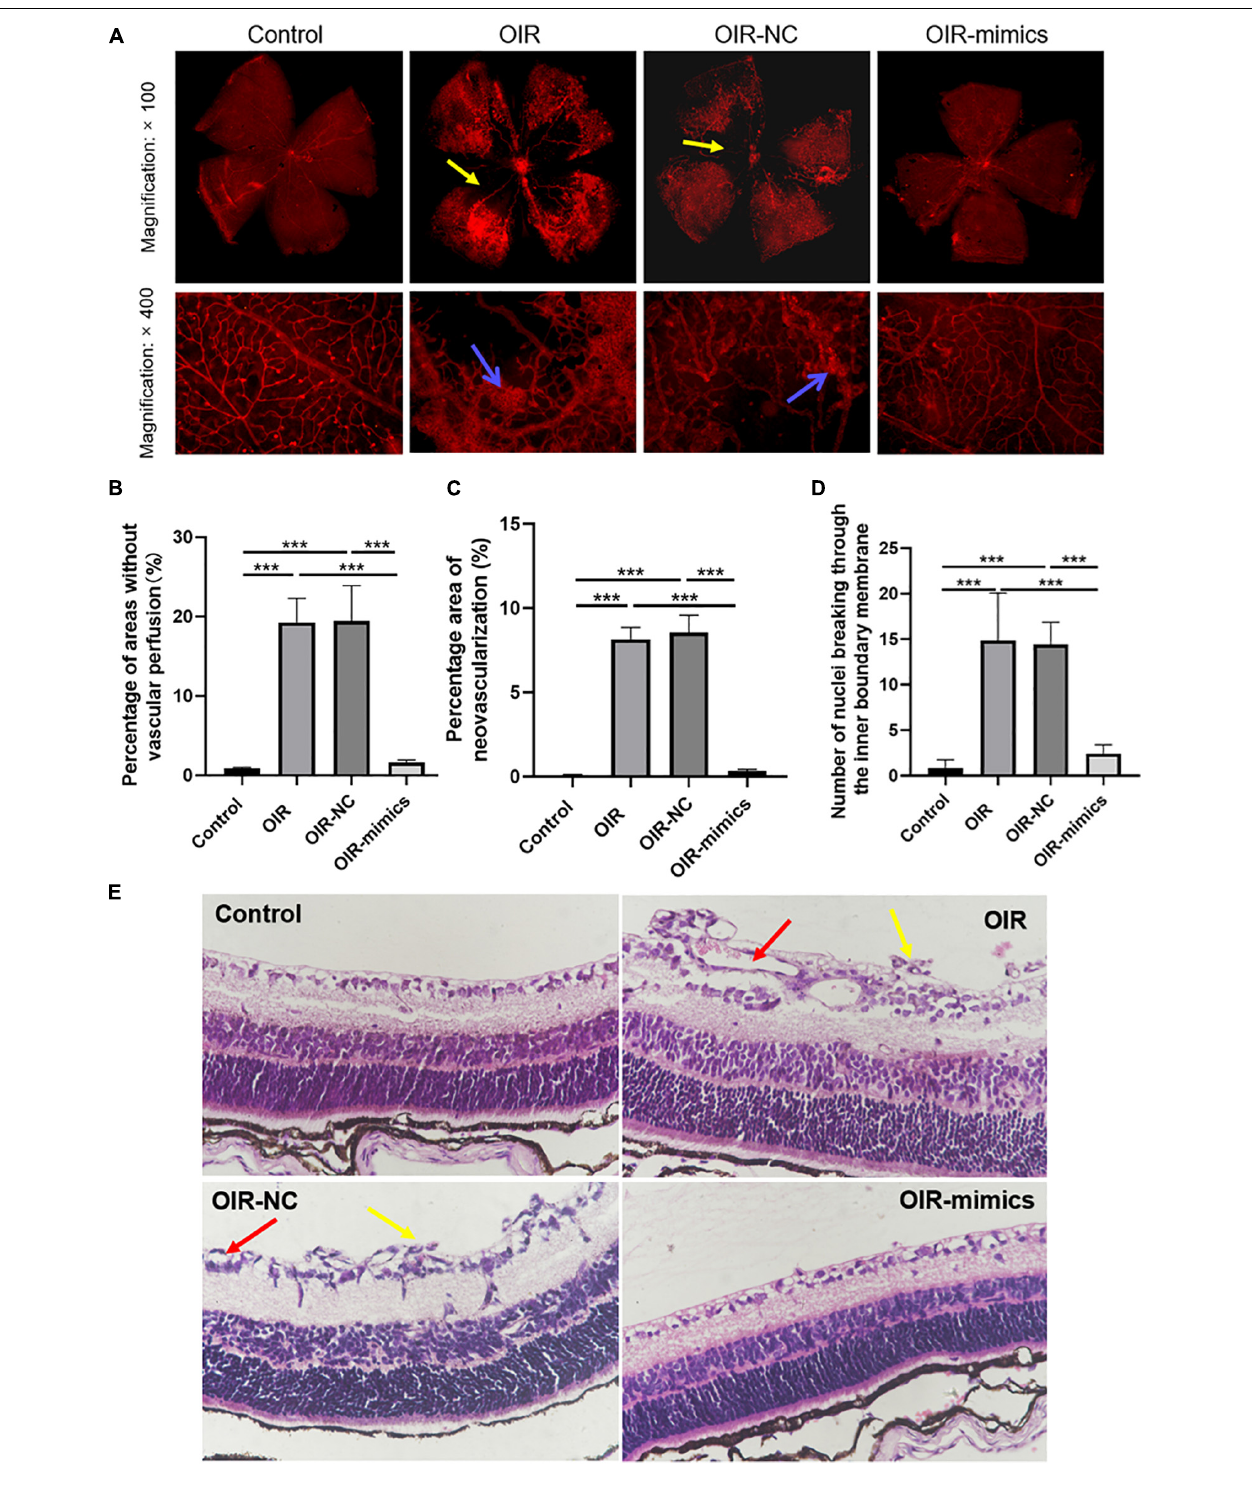
FIGURE 6 | Overexpression of miR-145-5p can reduce the degree of OIR retinal lesions. (A) Retinal vascular morphology of mice in different treatment groups, yellow arrows indicate non-perfusion area, blue arrows indicate neovascularization. (B) Percentage of areas without vascular perfusion (mean ± SD, n = 7). *** P < 0.001. (C) Percentage area of neovascularization (mean ± SD, n = 7), *** P < 0.001. (D) Number of nuclei breaking through the inner limiting membrane (mean ± SD, n = 7), *** P < 0.001. (E) HE staining images in different treatment groups, yellow arrows indicate nuclei breaking through the inner limiting membrane, red arrows indicate